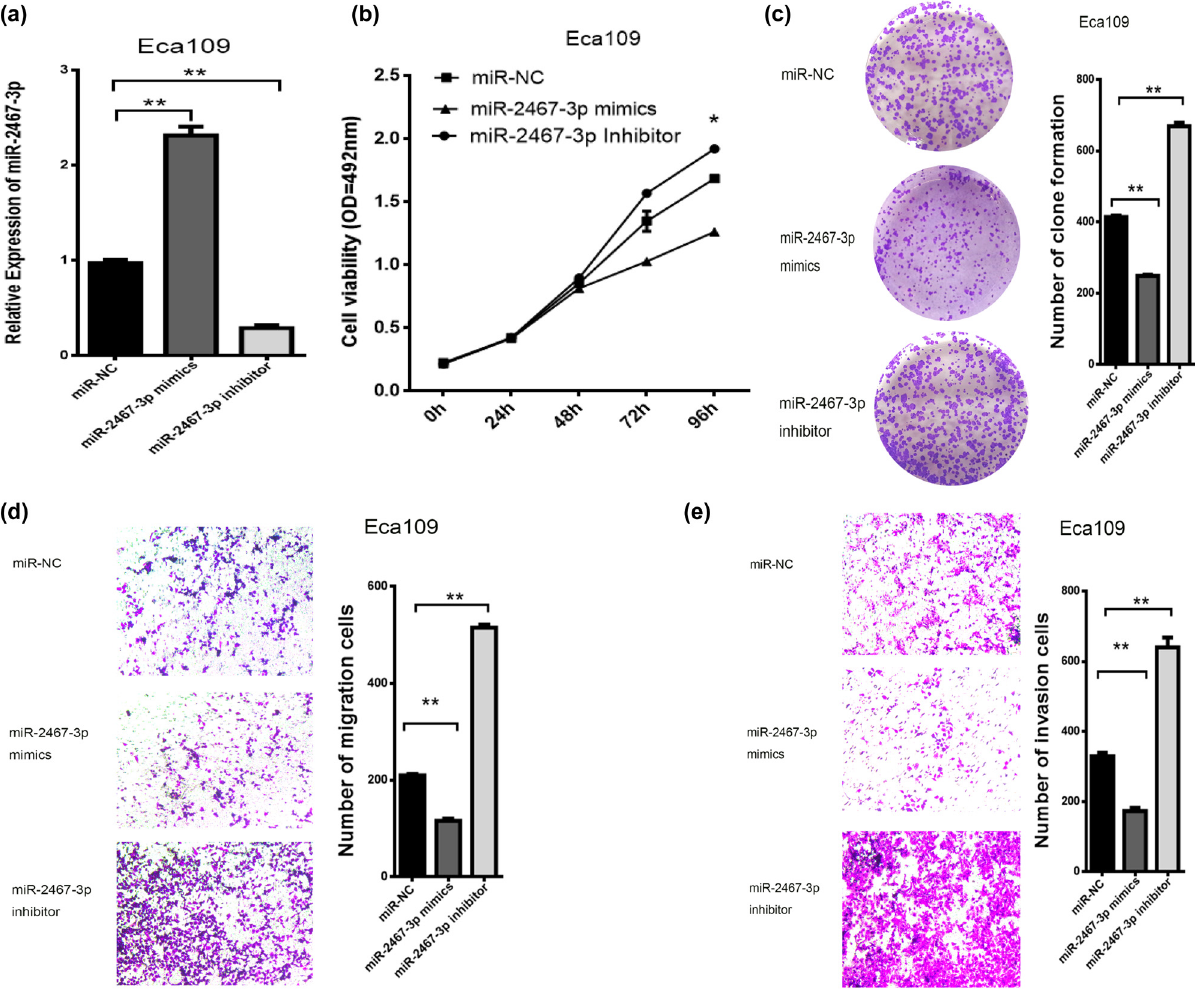
Figure 5: The biological functions of miR - 2467 - 3p in ESCC. ( a ) After treatment with miR - 2467 - 3p inhibitor or mimics, the transfection e ffi ciency was determined by qRT – PCR. ( b – e ) The e ff ects of miR - 2467 - 3p mimics and inhibitors on cell viability, clone formation, migration and invasion. *P < 0 .05 and **P <